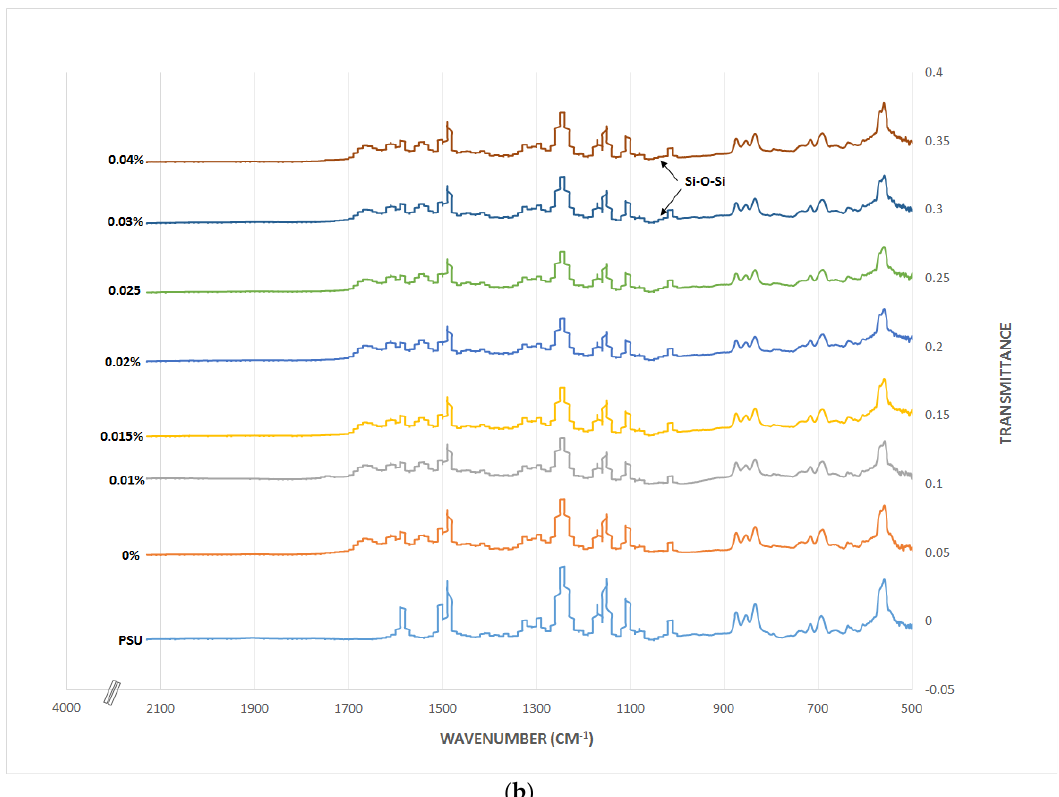
Figure 5. ( a ) Membrane’s ATR FT-IR spectra from embedding NPs in TMC solution; ( b ) Membranes from embedding NPs in MPD solution.